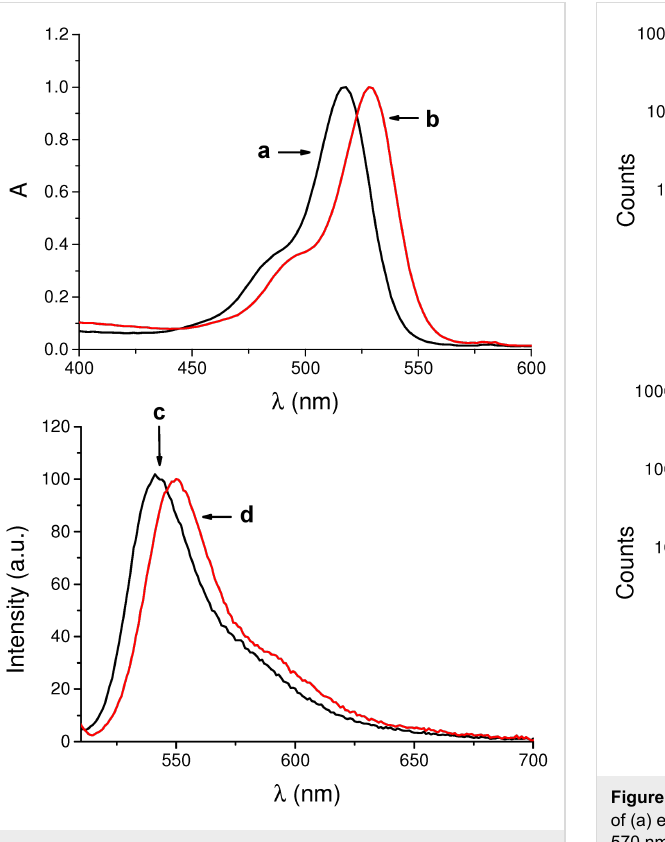
Figure 6: Normalized absorption spectra of aqueous solutions of (a) eosin Y ( 2 ) and (b) conjugate 2 – β -CD and fluorescence emission spectra of aqueous solutions of (c) 2 and (d) 2 – β -CD. λ exc = 490 nm. The fluorescence spectra were recorded with the two samples having the same absorbance at the excitation wavelength.